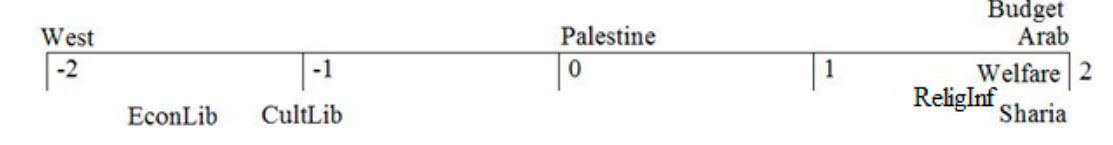
Figure 7. Ideological map of Egyptian parties, 1987. MB: Muslim Brotherhood.